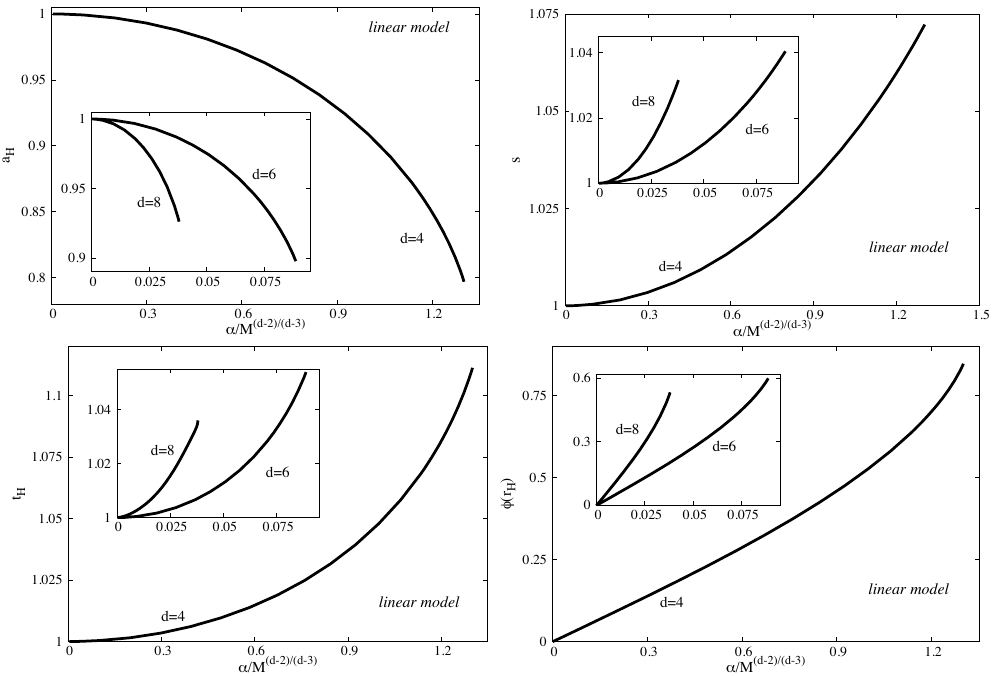
Figure 4 . Reduced area (top left panel), reduced entropy (top right panel), reduced temperature (bottom left panel) and the scalar (cid:12)eld at the horizon (bottom right panel) for BHs in the shift symmetric model in d = 4 ; 6 ; 8 spacetime